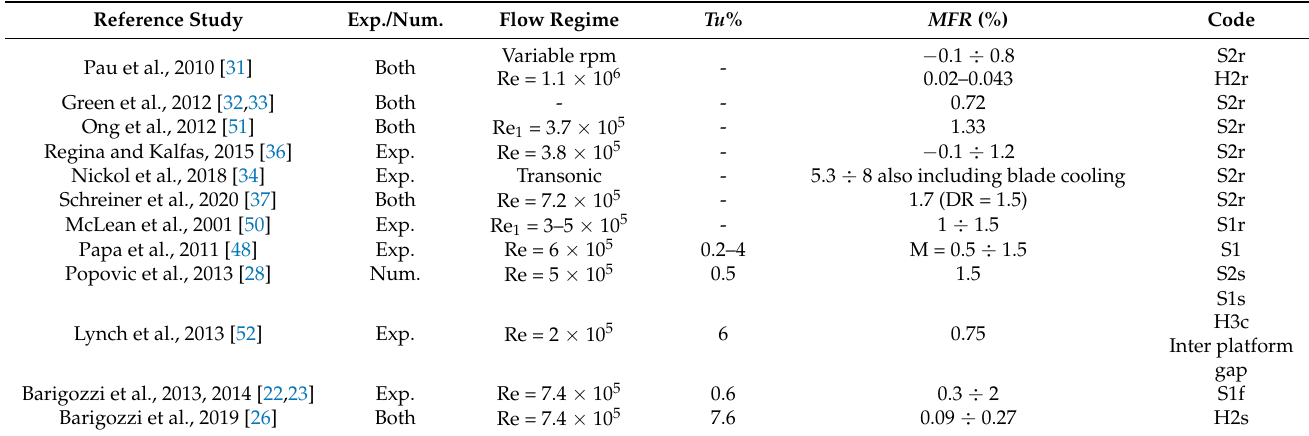
Table 3. Summary of considered literature—aerodynamic